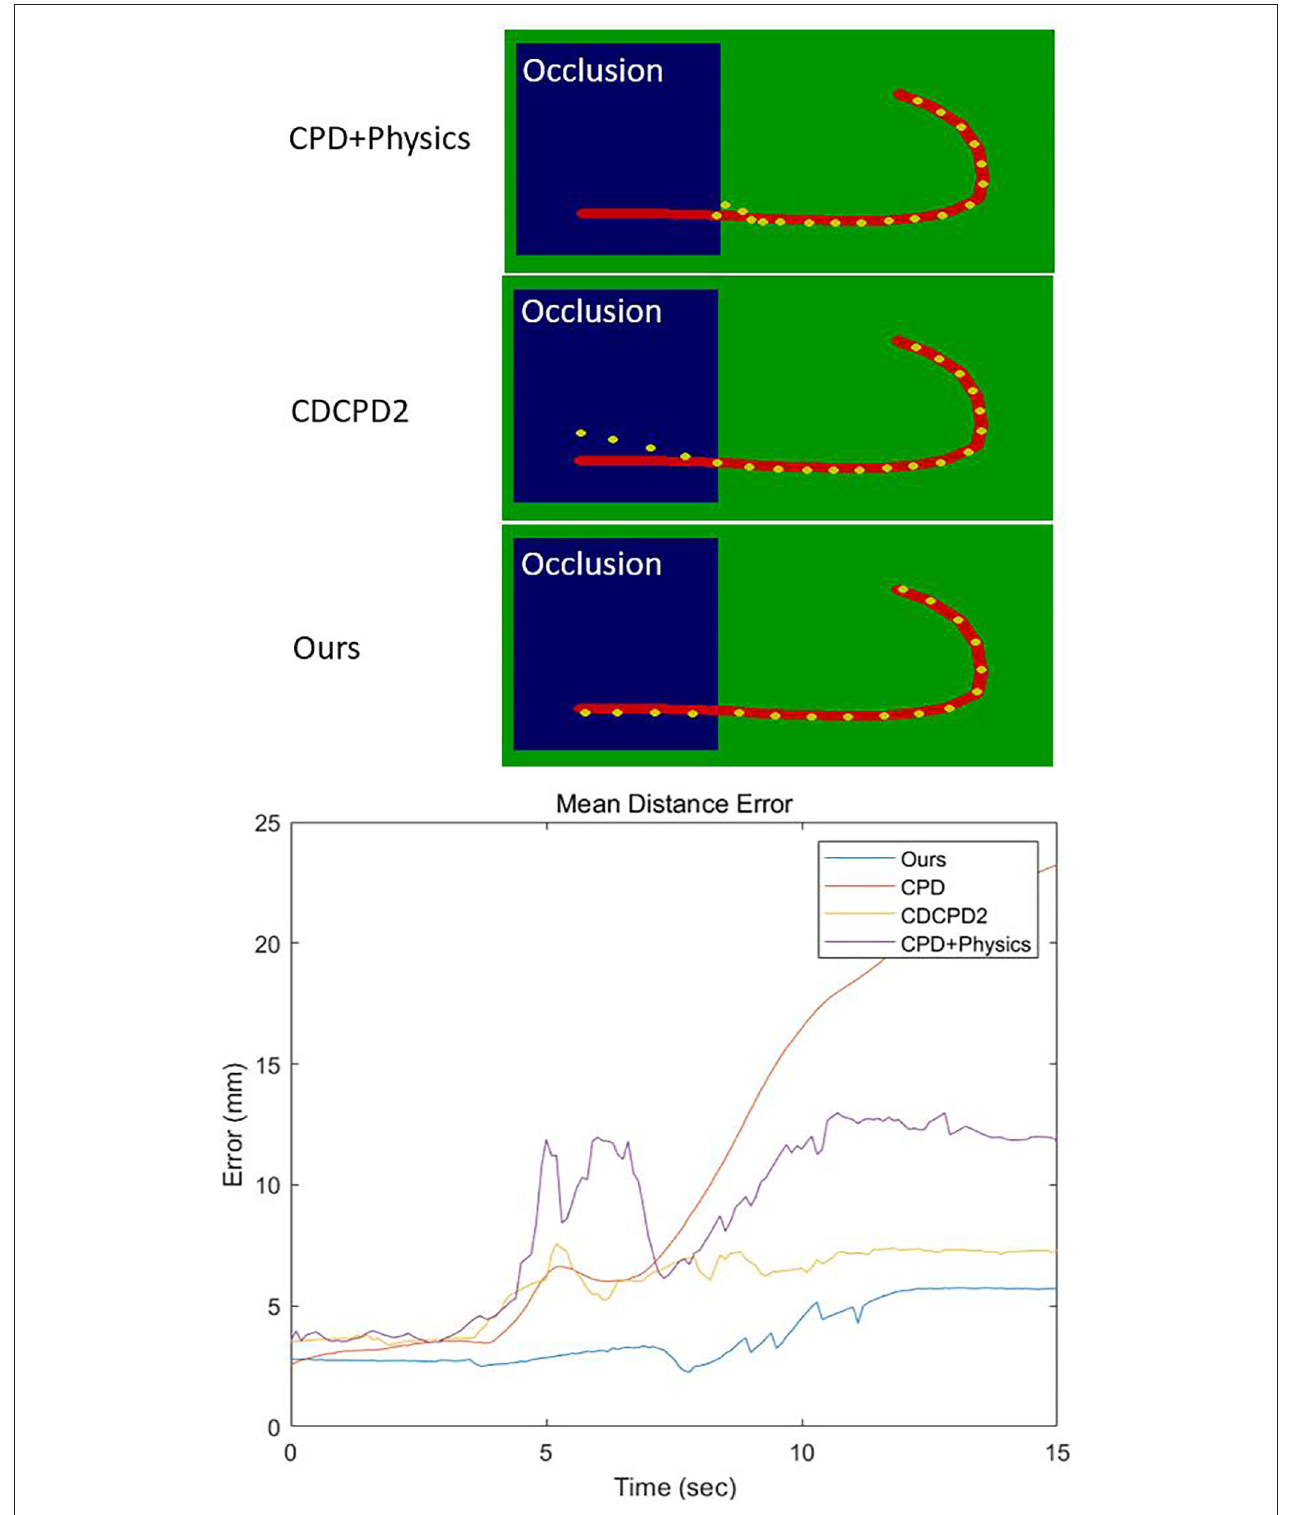
FIGURE 5 | The upper figures are the results of tracking after 15 s. The blue part represents the occlusion. The red curve is the ground truth. Yellow dots are the registration results of the three algorithms. The bottom image is the mean distance error within the 15 s.